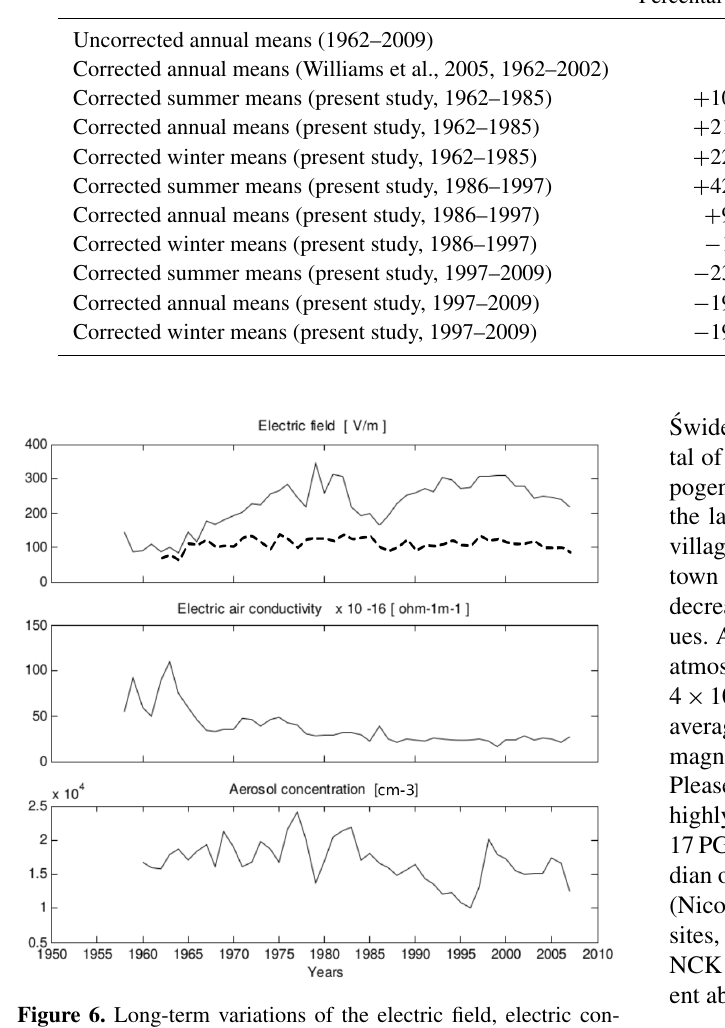
Figure 6. Long-term variations of the electric field, electric con- ductivity of air, and aerosol concentration at ´Swider observatory (Poland). Dashed line on the uppermost panel denotes the corrected annual means measured at NCK. Adopted with permission from Fig. 4 in Dziembowska